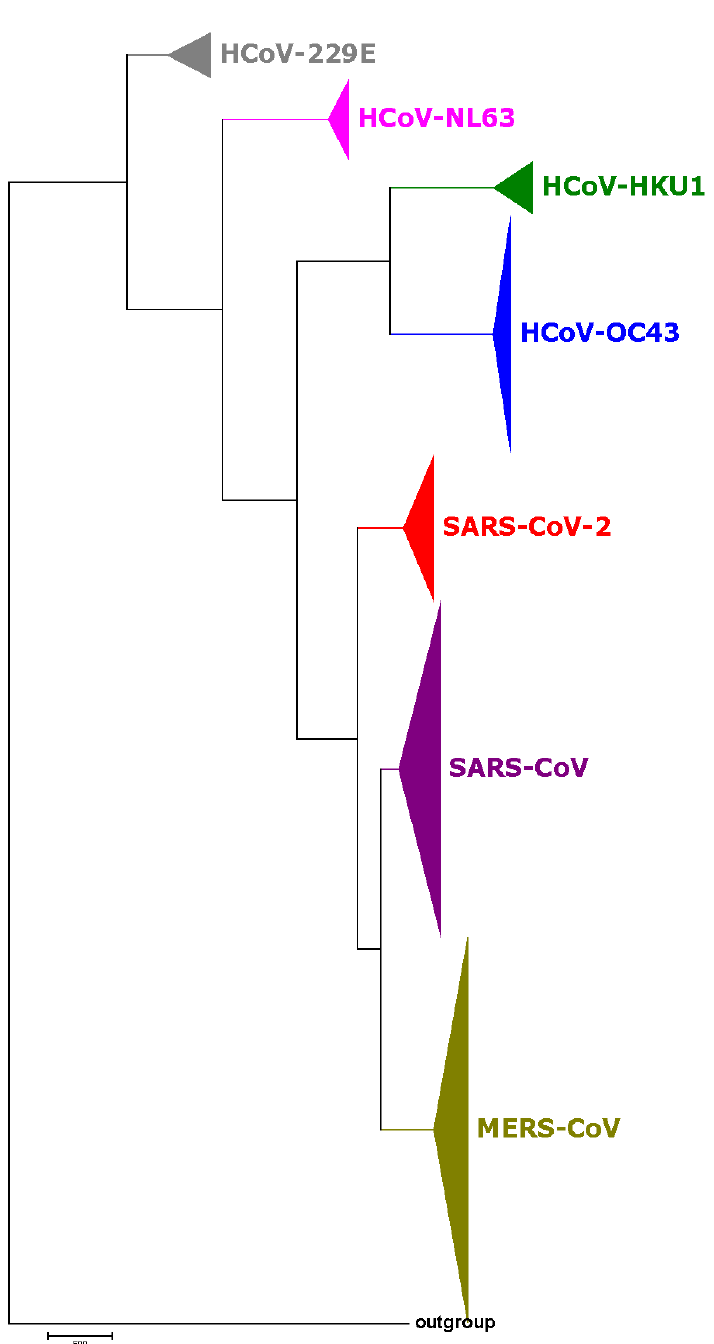
Figure 2. The phylogenetic tree of 95 SARS-CoV-2 and 731 known coronaviruses based on BioNJ and Natural Vector algorithm. Different colors represent different types of coronaviruses that can infect